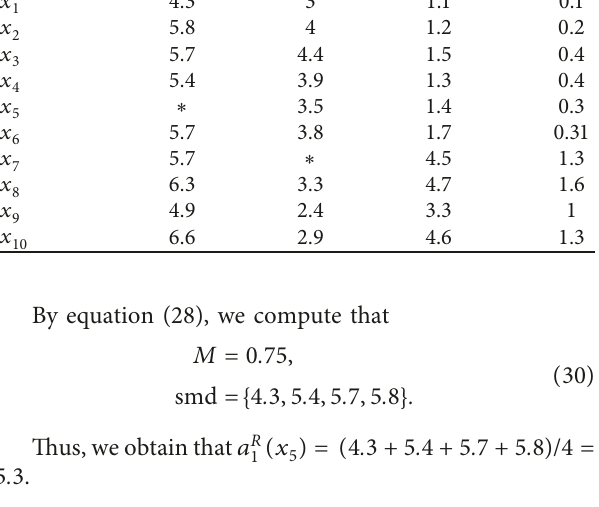
Table 4: Original dataset of Table 3. Objects